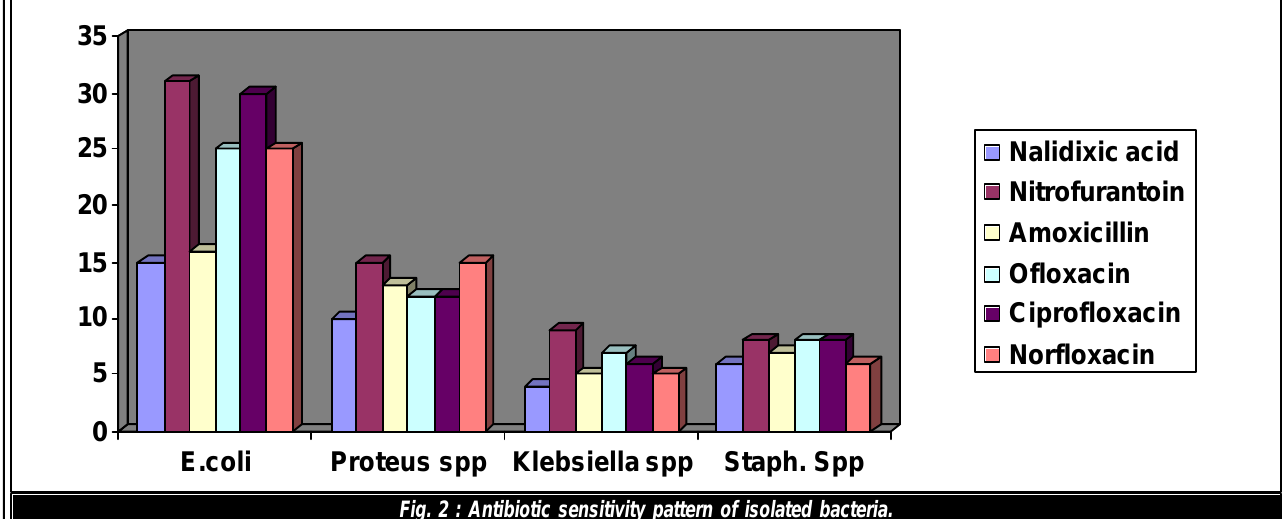
Fig. 2 : Antibiotic sensitivity pattern of isolated